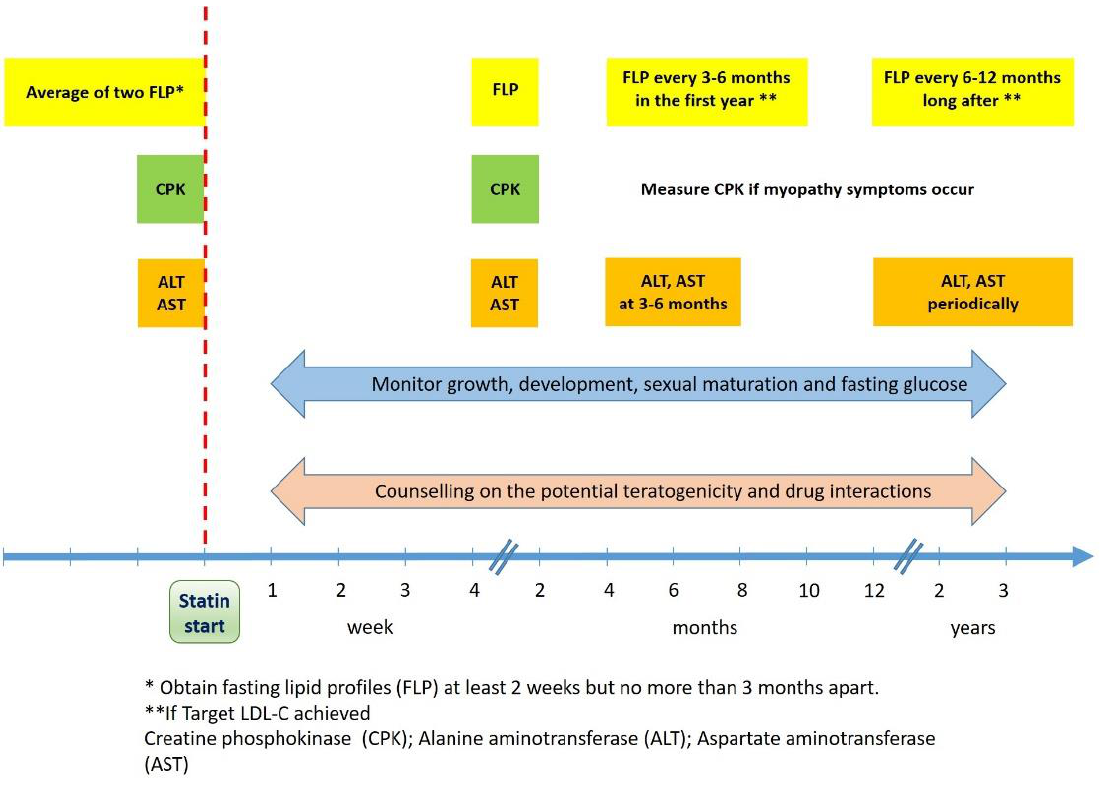
Figure 3. Surveillance scheme in children and adolescents taking statins.